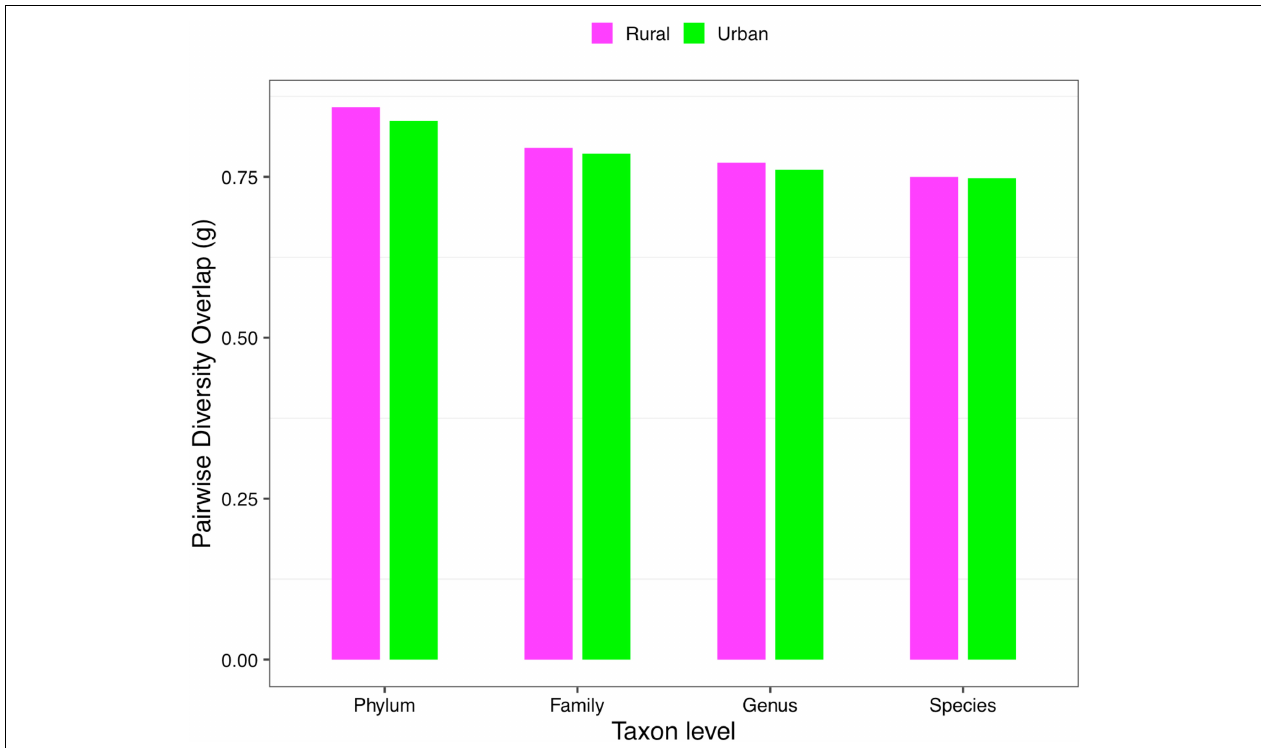
FIGURE 4 | The PDO profiles of the rural and urban cohorts at phylum, family, genus, and species levels when diversity order q = 0 (Scheme